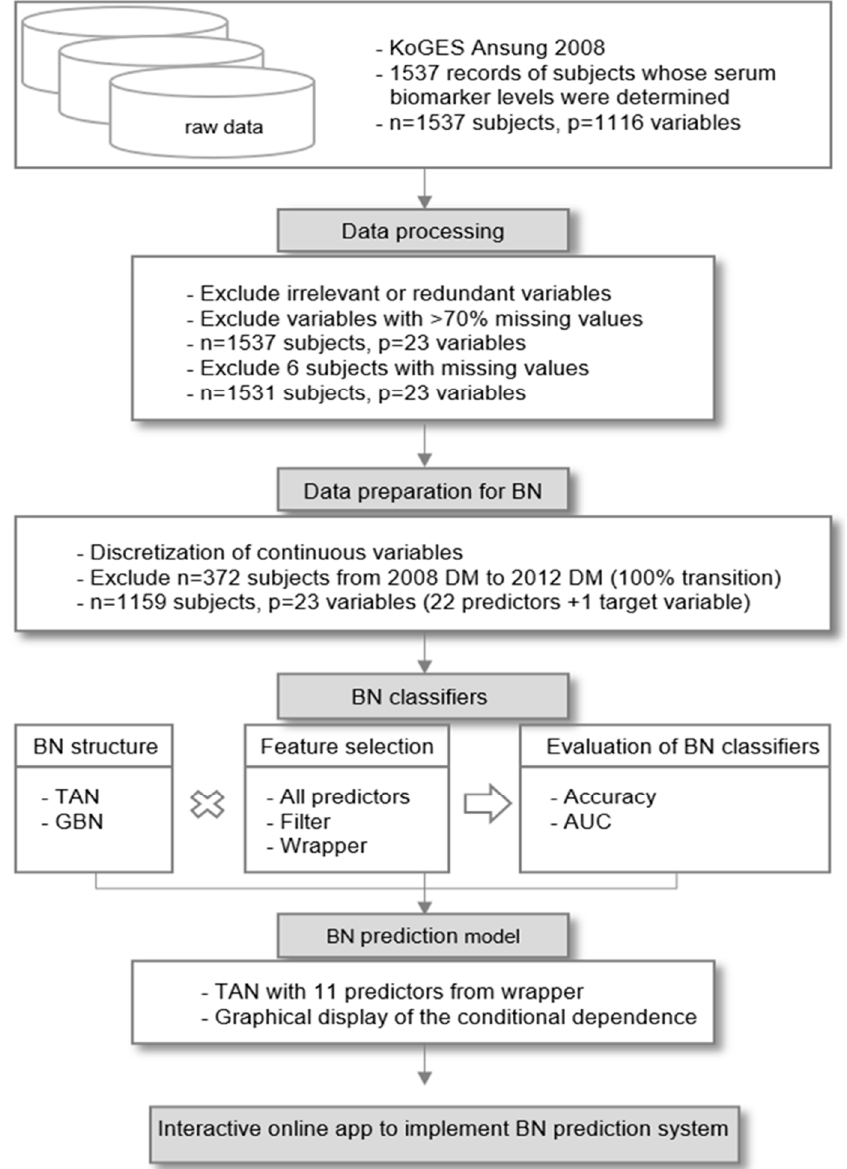
Figure 1. Process of developing the BN prediction app for diabetes progression.